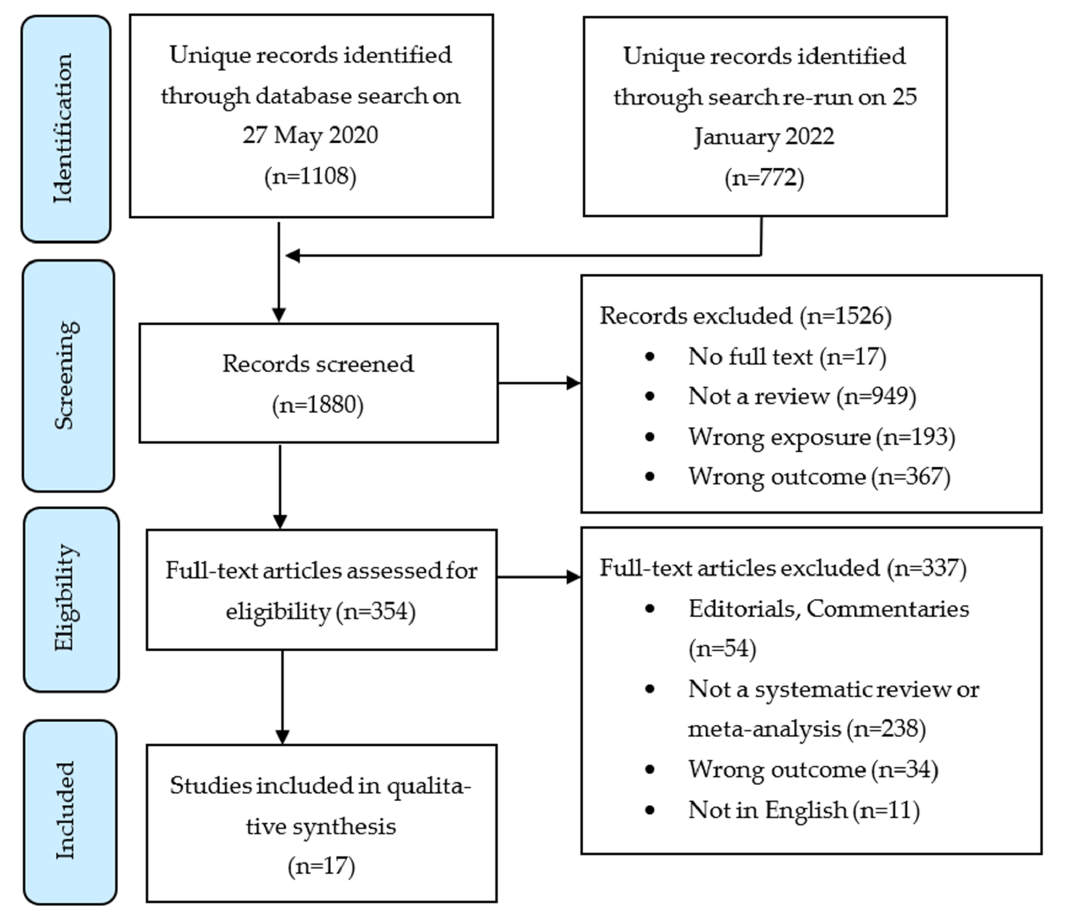
Figure 1. Flow diagram of the selection process for the umbrella review.